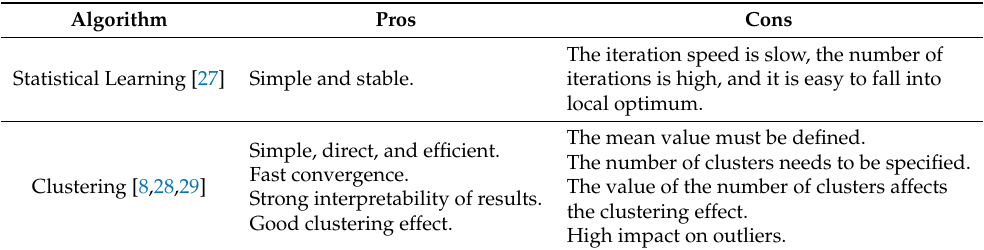
Table 3. Comparison of different statistical-based machine learning algorithms for intelligent identifi- cation of